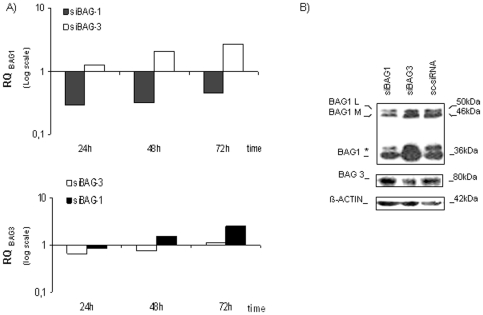
BAG1 and BAG3 mRNA and protein expression in HL60 cells.A) HL60 cells were subjected to silencing of BAG1 (siBAG1) and BAG3 (siBAG3) and subsequently checked for relative mRNA expression. RQ-values at 24 h, 48 h, and 72 h of transfection are shown after being normalized to GUS gene and calibrated to sc-siRNA values. The RQ values are presented on a logarithmic scale. B) WB analysis of BAG1 and BAG3 expression after silencing is presented, as well as the reciprocal protein increase induced after single silencing. β-ACTIN was a control for an equivalent sample loading.